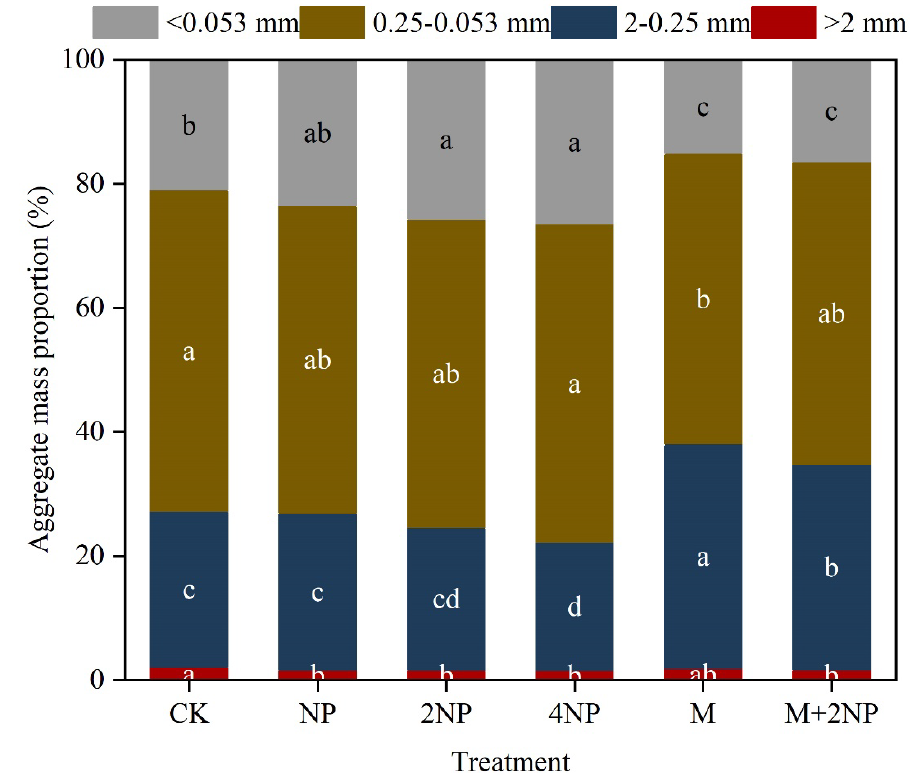
Figure 1. The size distribution of soil aggregates. Different lowercase letters show significant differences among fertilization treatments in the same aggregate fractions ( p < 0.05). Values are given as means ± SD ( n = 3). Abbreviations: CK = no fertilizer; NP = low−dose chemical fertilizer; 2NP = moderate−dose chemical fertilizer; 4NP = high−dose chemical fertilizer; M = normal−dose organic fertilizer; M+2NP = normal−dose organic fertilizer + moderate−dose chemical fertilizer.